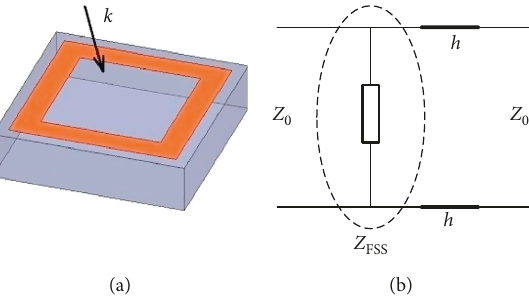
Figure 3: Structure of the single-layer band-stop FSS. (a) SL element of the FSS. (b) Equivalent circuit of the FSS.